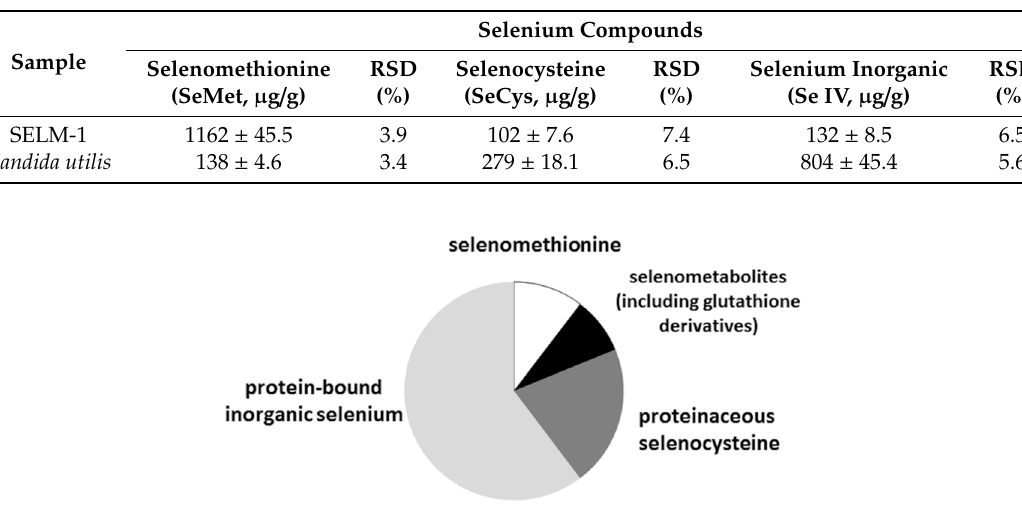
Figure 4. Percentage distribution of selenium among different selenium compounds groups.